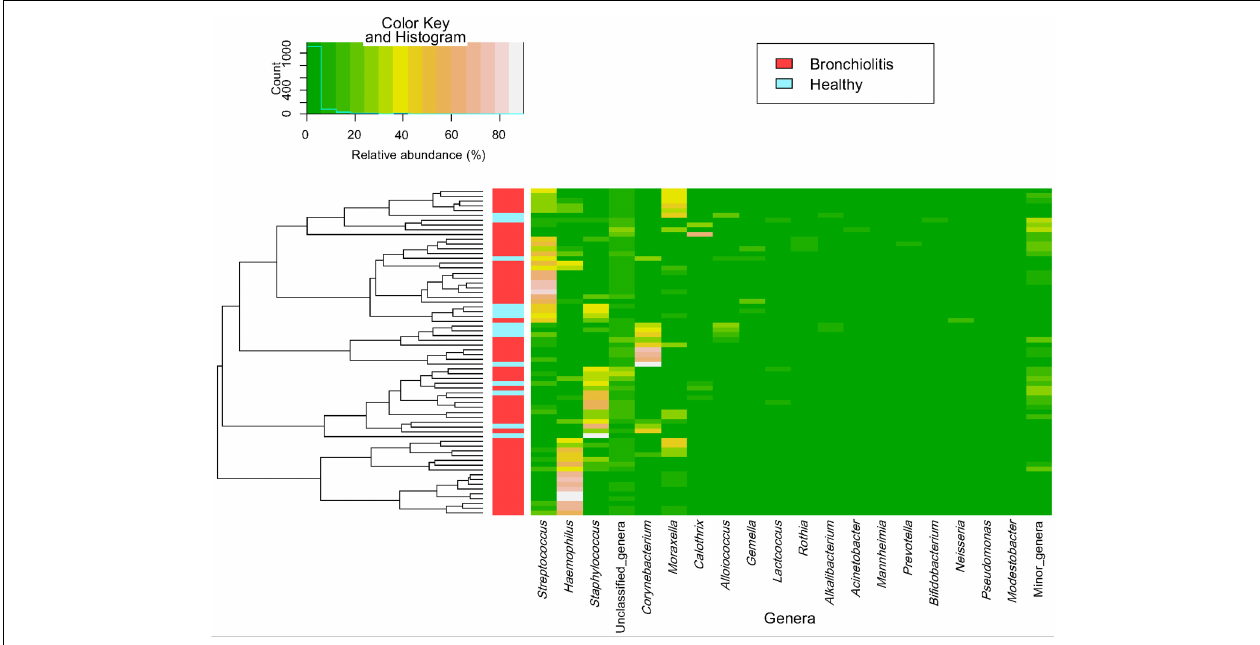
FIGURE 3 | Heatmap of bacterial profile at the genus level in the microbiota of nasal samples. The plot depicts the relative abundance of each genera ( x -axis clustering) within each sample ( y -axis clustering). The relative abundances of the genera are represented by color intensity. The vertical bar (left) identifies samples from control ( n = 14; blue color) and bronchiolitis ( n = 54; red color)